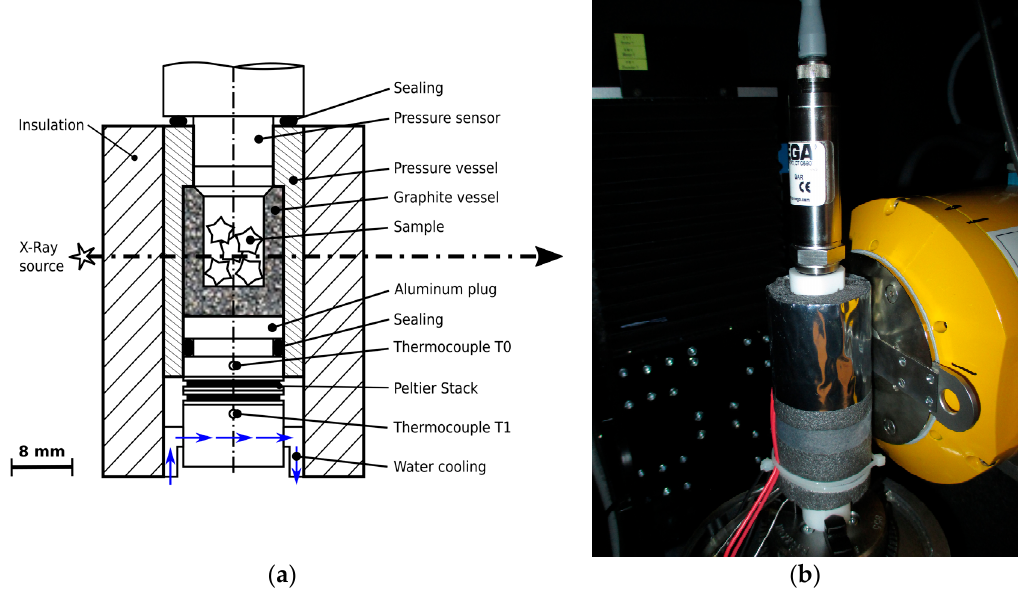
Figure 9. The experimental setup used in this study: ( a ) sketch of the pressure-monitored cooling stage. The dash-dotted line indicates the beam axis of the µCT; and ( b ) photograph of the setup as it is used in this work. The shiny grey part in the lower center is the radiation shield of the insulation layer of the cooling stage. The yellow part in the background is the X-ray tube of the µCT.